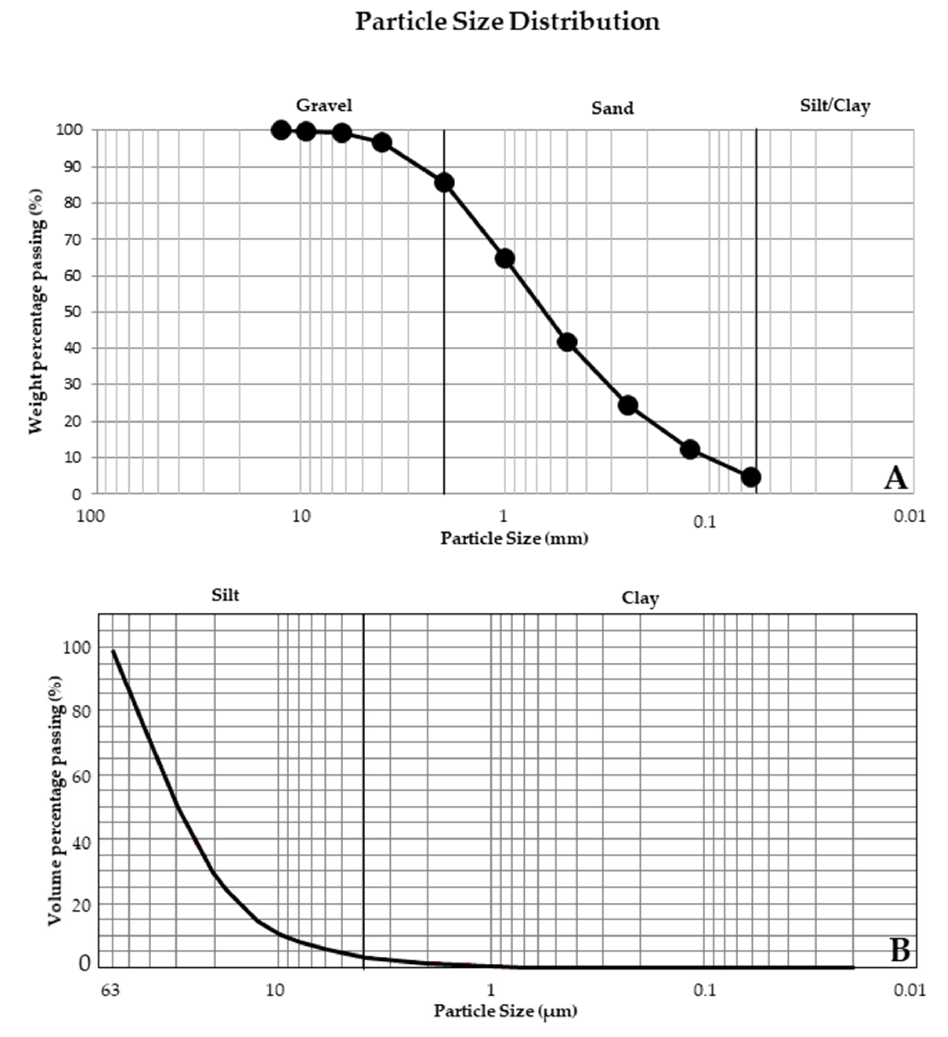
Figure 9. Cumulative grain-size frequency curves of the volcaniclastic deposits. ( A ) Distribution obtained by dry mechanical sieving of the particle size > 63 µ m. The curve indicated that they consisted of gravelly sands with grains from very thick to very fine. ( B ) Distribution obtained by laser diffraction granulometric analysis of the grain size < 63 µ m. The curve indicated that they consisted of silts (d0.9: 53.145 µ m; mode: 45.870 µ m).